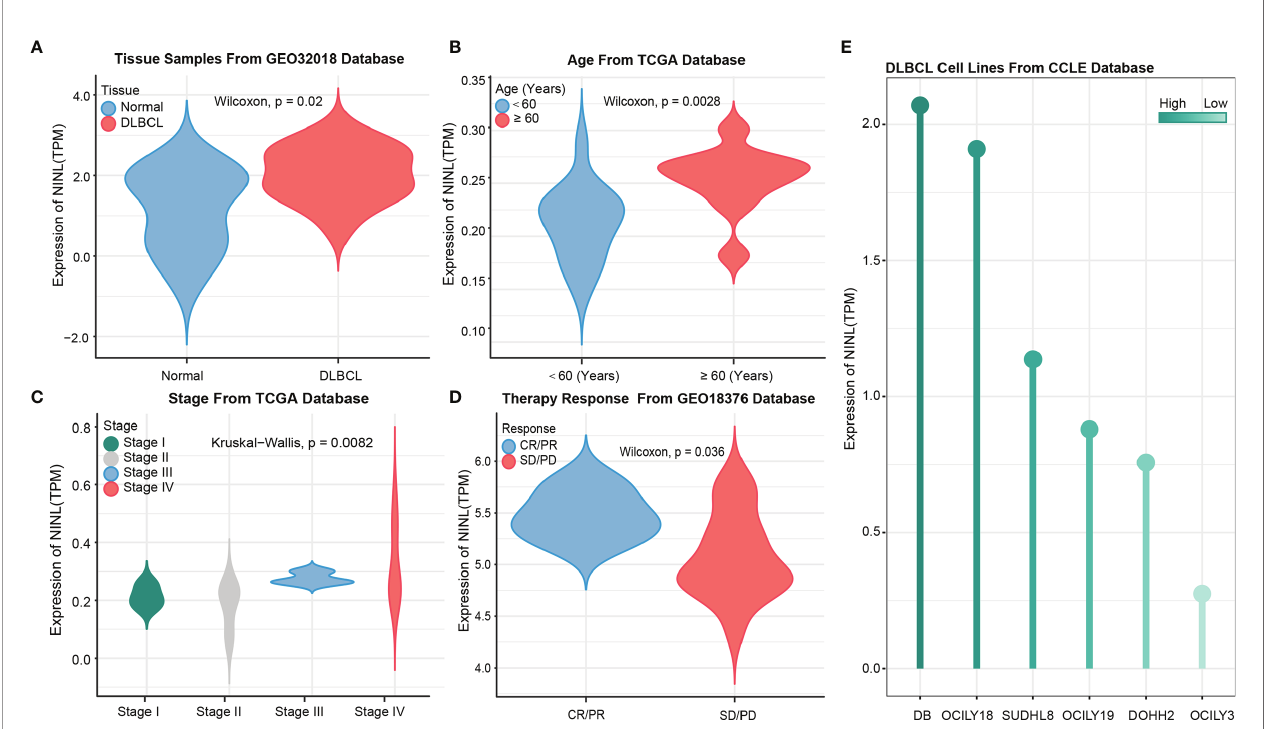
FIGURE 4 | NINL expression validation in tissues and cell lines. NINL expression validation between normal and tumor groups from GEO dataset (A) and this gene expression validation in age and stage groups from TCGA dataset (B, C) , therapy response also validated in GEO dataset (D) . Expression in cell lines was performed in CCLE dataset (E) .